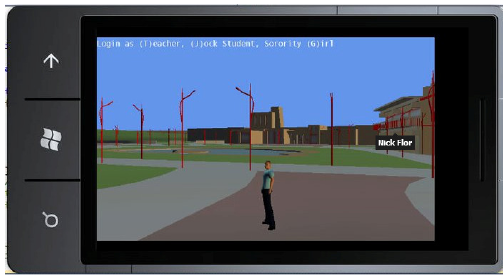
Figure 1. Virtual UNM Campus Developed by